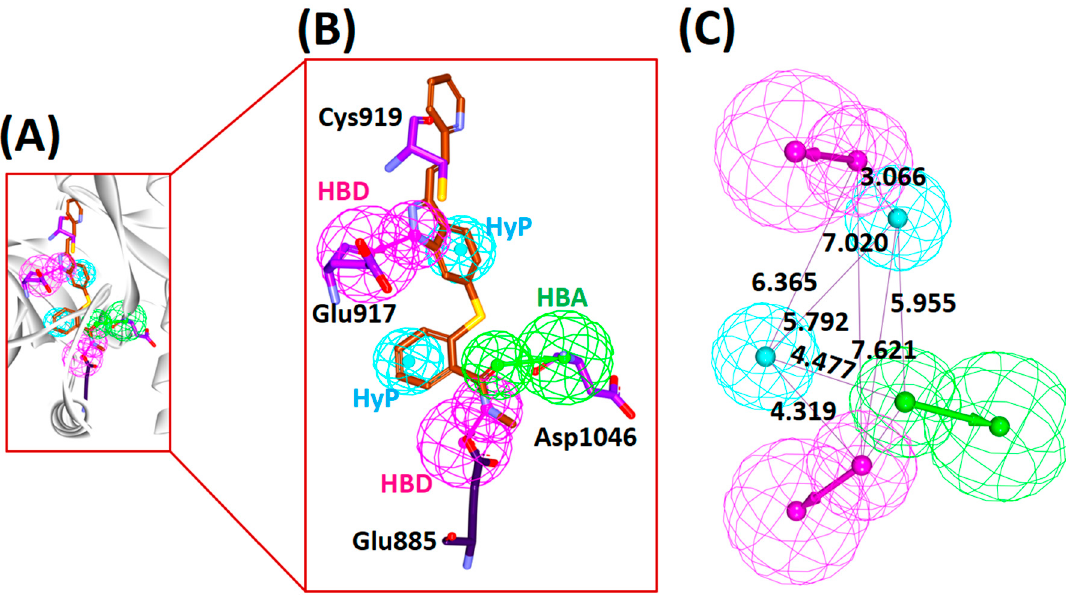
Figure 1. Structure-based pharmacophore model generation. ( A ) Generated pharmacophore model at proteins active site. ( B ) Pharmacophore features complementary to the key residues. ( C ) Interfeature distance between the pharmacophore features. HBA, hydrogen bond acceptor; HBD, hydrogen bond donor; HyP, hydrophobic. Table 1. Receptor-ligand based pharmacophore models and their distinct features. Model